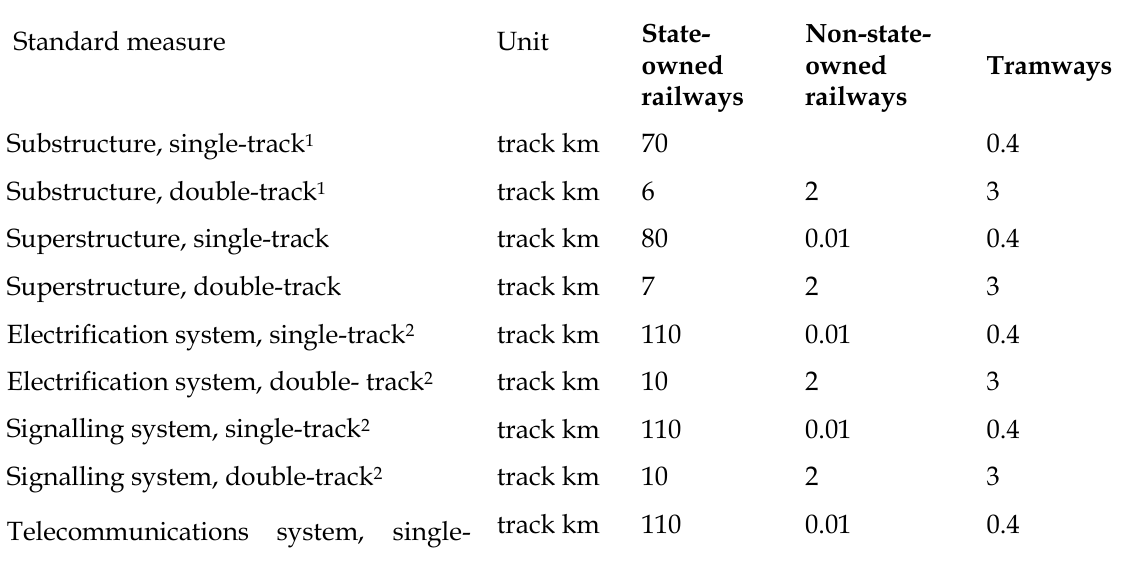
Table A2. New construction of rail infrastructure during 1 year (arithmetic mean over the period 2010 – 2015): resulting inventory of standard measures (substructure,